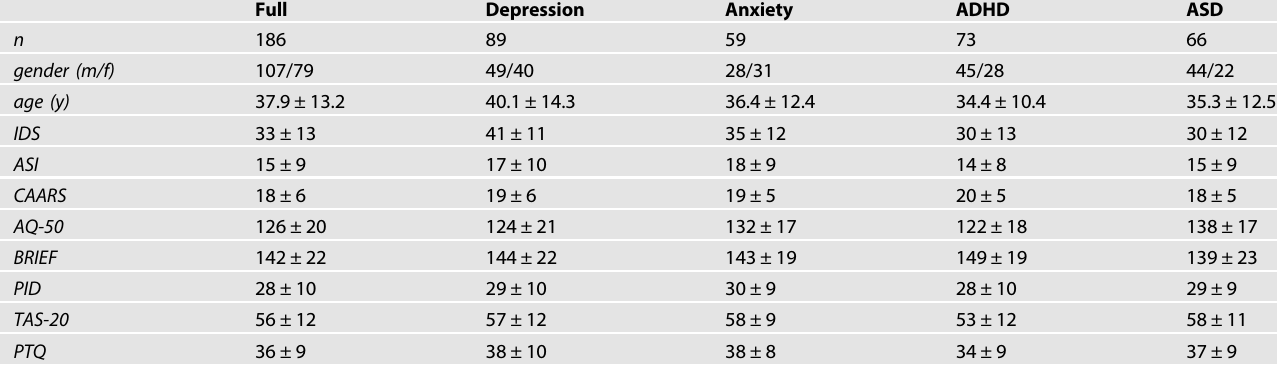
Table 1. Demographics and questionnaire data for full sample and per diagnostic category.